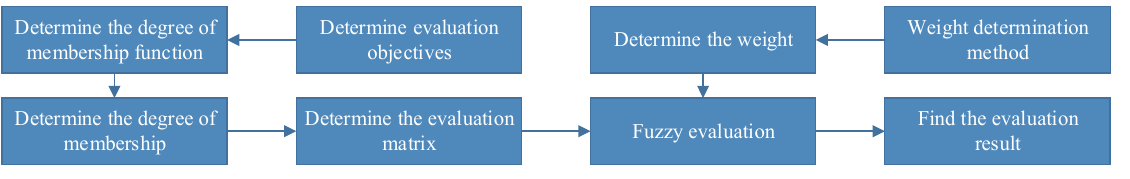
Figure 3. Flowchart of MOPSO.